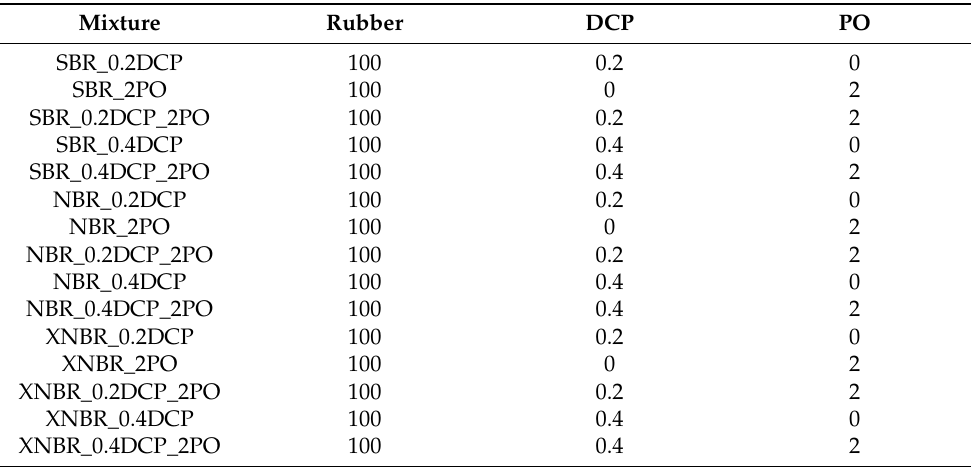
Table 1. Composition of the rubber compounds studied